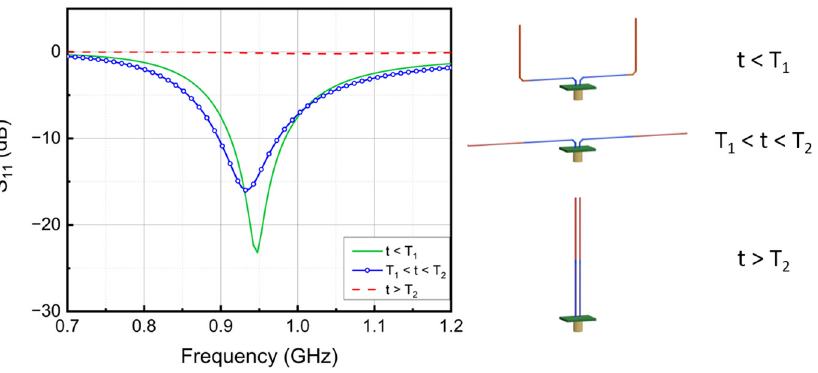
Figure 3. Simulated frequency response of the designed ShMoA and its corresponding shape at different temperatures.